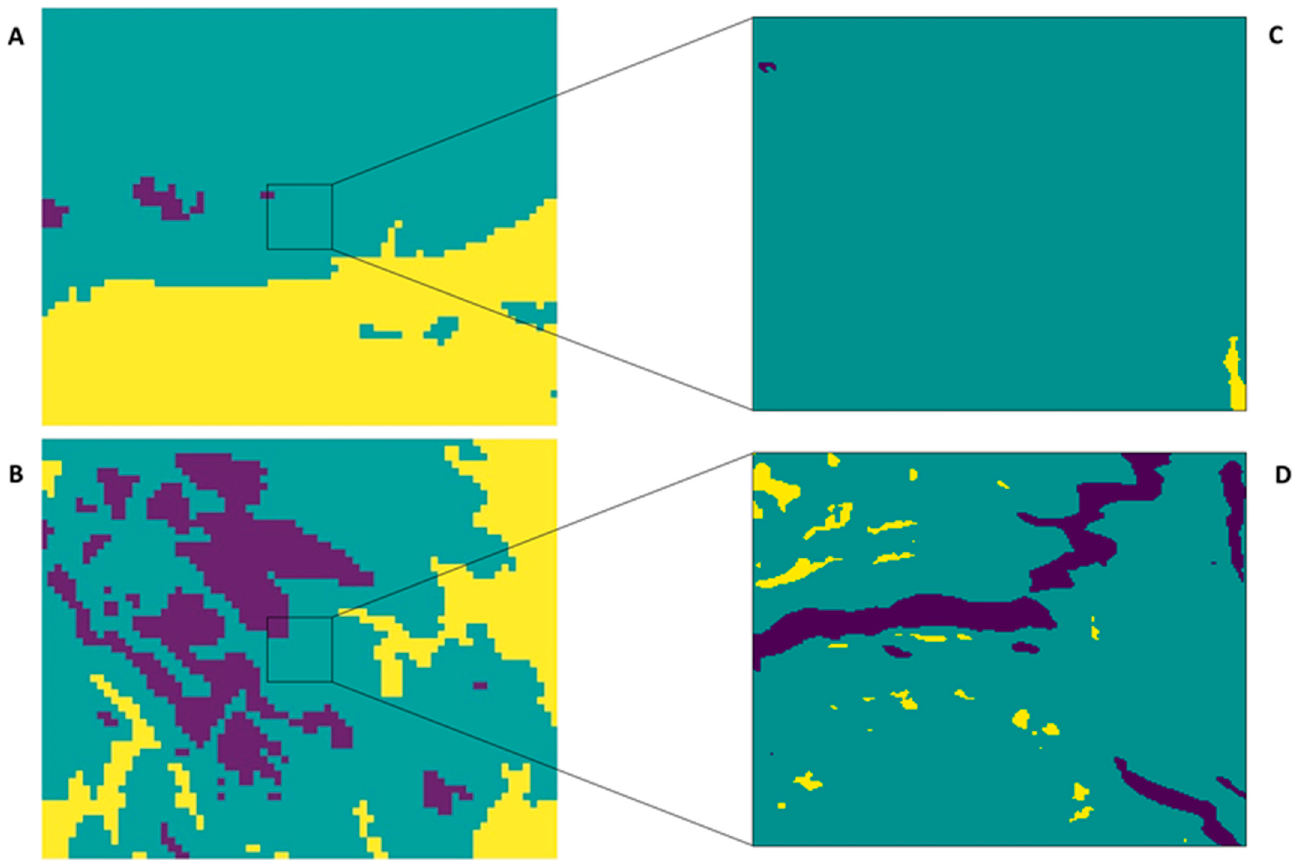
Figure 3. Exposure to analogous and non ‐ analogous maximum July temperatures from 1980 ‐ 89 to 2010 ‐ 19 in the Sierra de Gredos ( A , C ) and Sierra de Albarracín ( B , D ). Green represents analogous conditions, while yellow indicates non ‐ analogous “gained” conditions and purple represents non ‐ analogous “lost” conditions. ( A , B ): Mesoscale 50 km squares, 1 km resolution; ( C , D ): Microscale 6 km squares, 30 m resolution, modelled for H10—grassland.